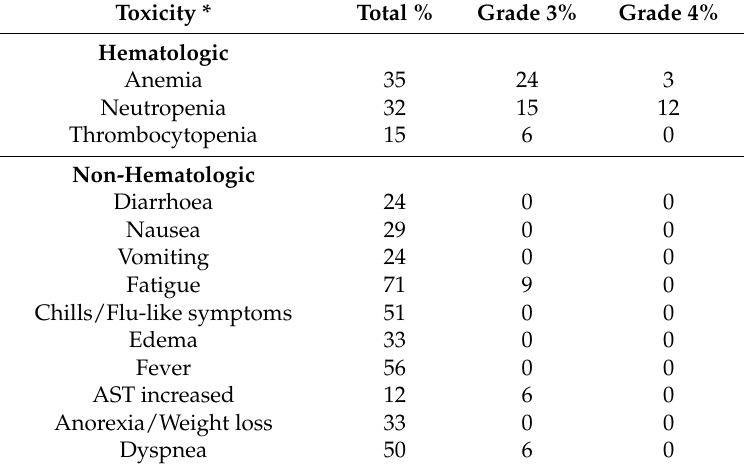
Table 2. Most commonly identified toxicities for pelareorep in combination with gemcitabine. (>10% of patients).